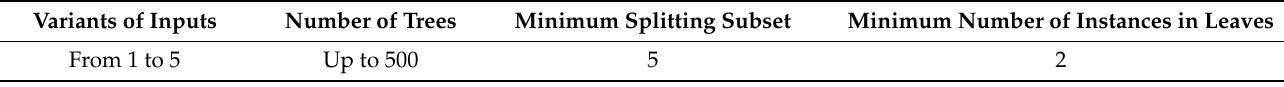
Table 3. Variants of the analyzed topologies of the random forest